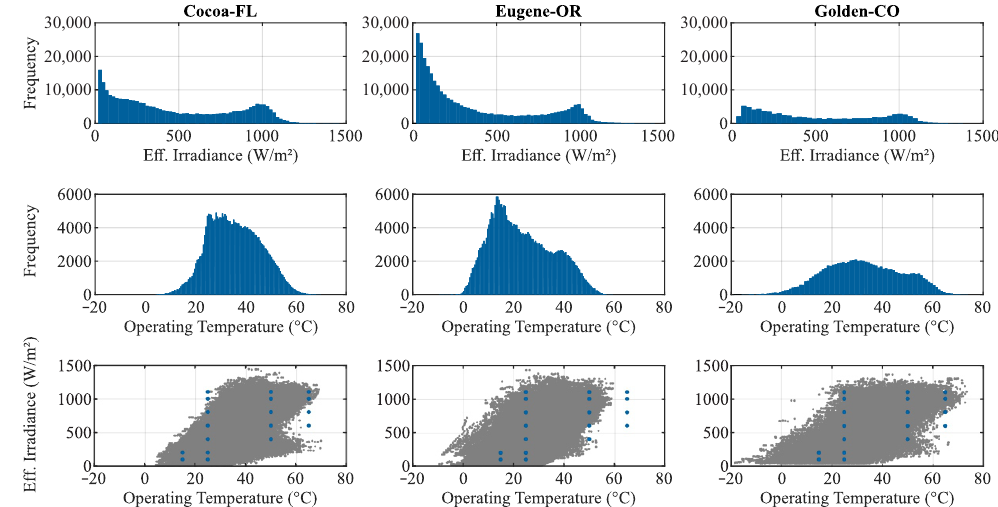
Figure 2. Overview of the operating conditions recorded for the PV modules under study in Cocoa- Fl (left), Eugene-OR (center) and Golden-CO (right) [43]. In the graphs of effective irradiance versus operating temperature of the PV modules (bottom), the operating conditions in which the characteristics of the PV modules under study were possible to be measured in the laboratory are highlighted [43].